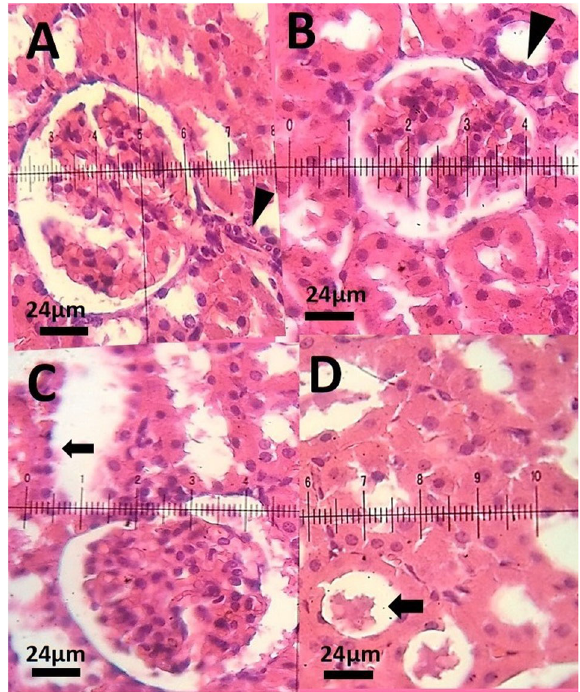
Fig. 10 A Hematoxylin – eosin-stained kidney sections of a control rat showing (G) normal glomeruli, macula densa apparatus, and normal proximal tubules H&E staining (×40); B Kidney sections of a rat received the 2.5 mg/kg dose of niosomal PTX showing normal glo- merulus and normal macula densa (arrow) H&E staining (×40); C Kidney section of a rat received the 5 mg/kg dose of niosomal PTX, arrow shows cellular vacuolation of renal tubules. H&E staining (×40); D Kidney section of a rat treated with free PTX, narrowing of proximal tubules and hyaline casts (arrow), H&E staining (×40)